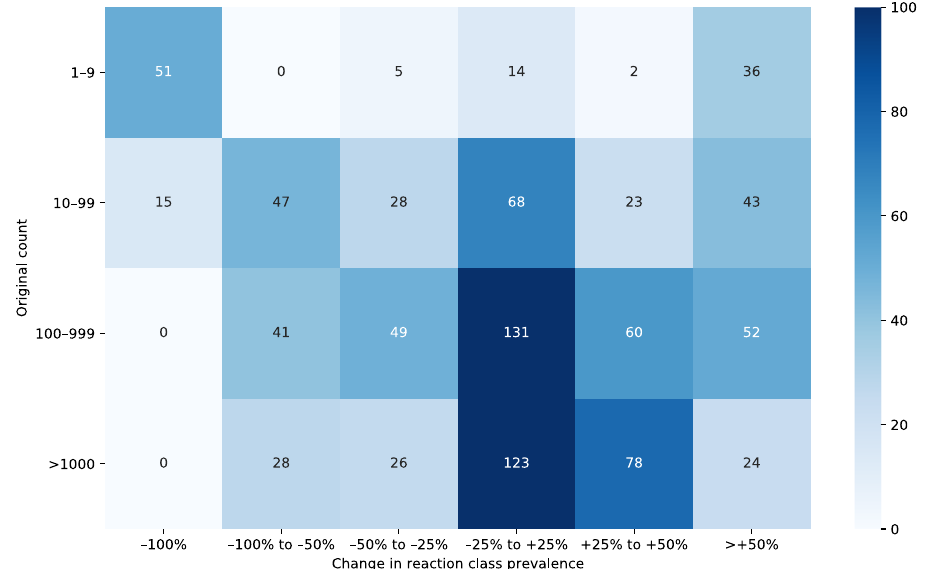
Fig. 3 Differences in class prevalence between the original data and the generated data set. As an example, this fi gure can be read in the following manner: a total of 60 reaction classes, each occurring between 100 and 999 times in the original reaction data set, are represented between 25% and 50% more frequently in the data set of 693,517 reactions.